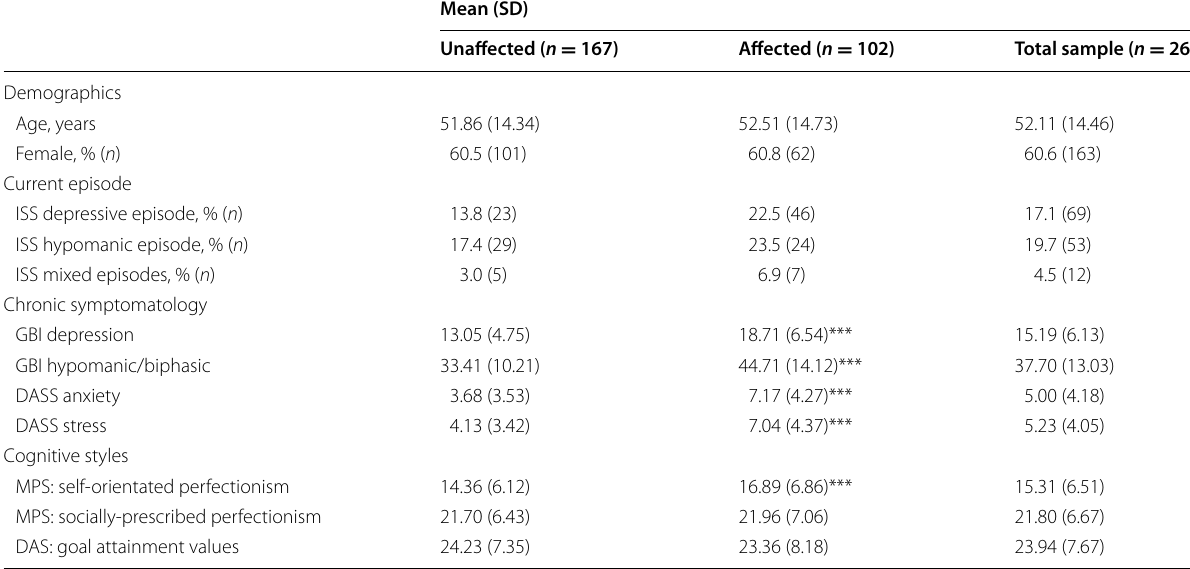
Perfectionism Scale, DAS Dysfunctional Attitudes